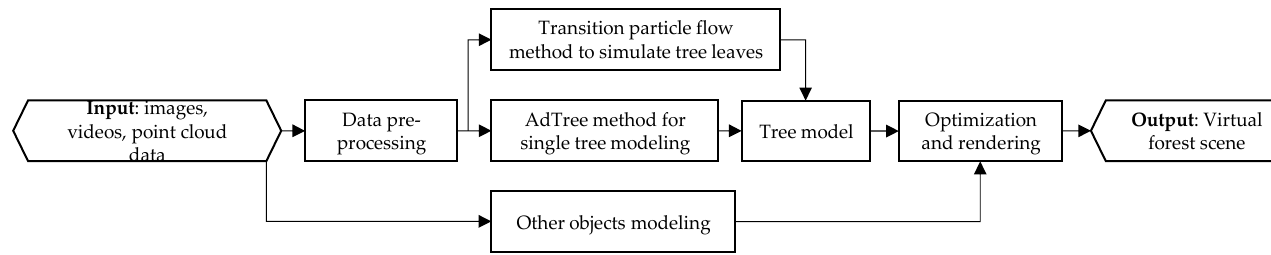
Figure 2. Flowchart of virtual forest modeling.